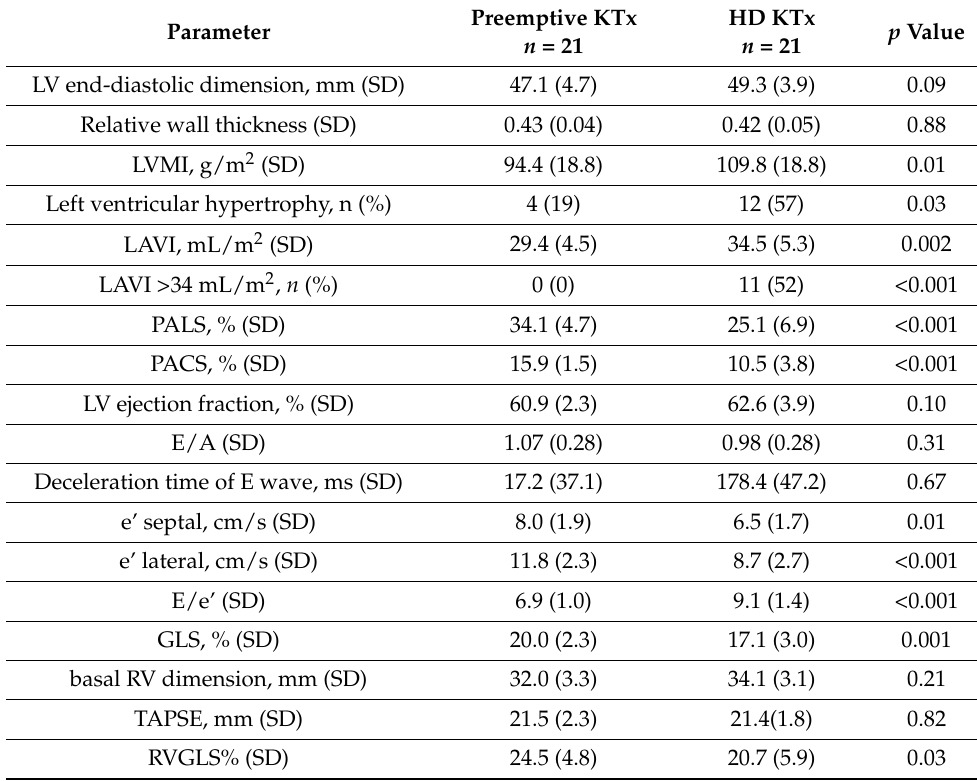
Table 2. Echocardiographic characteristics of the studied